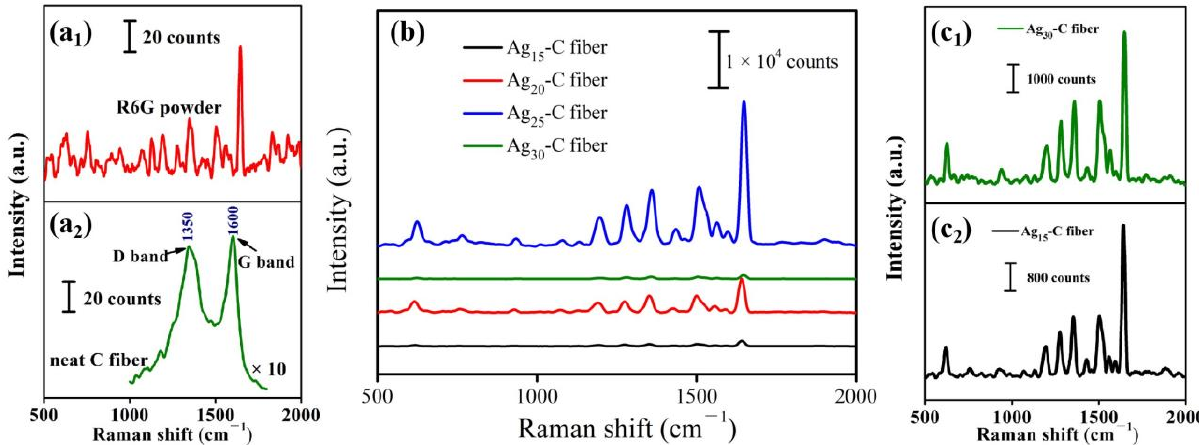
Figure 5. ( a , b ) Amplifying FE-SEM images of Ag 25 -C-fiber substrate from side view.